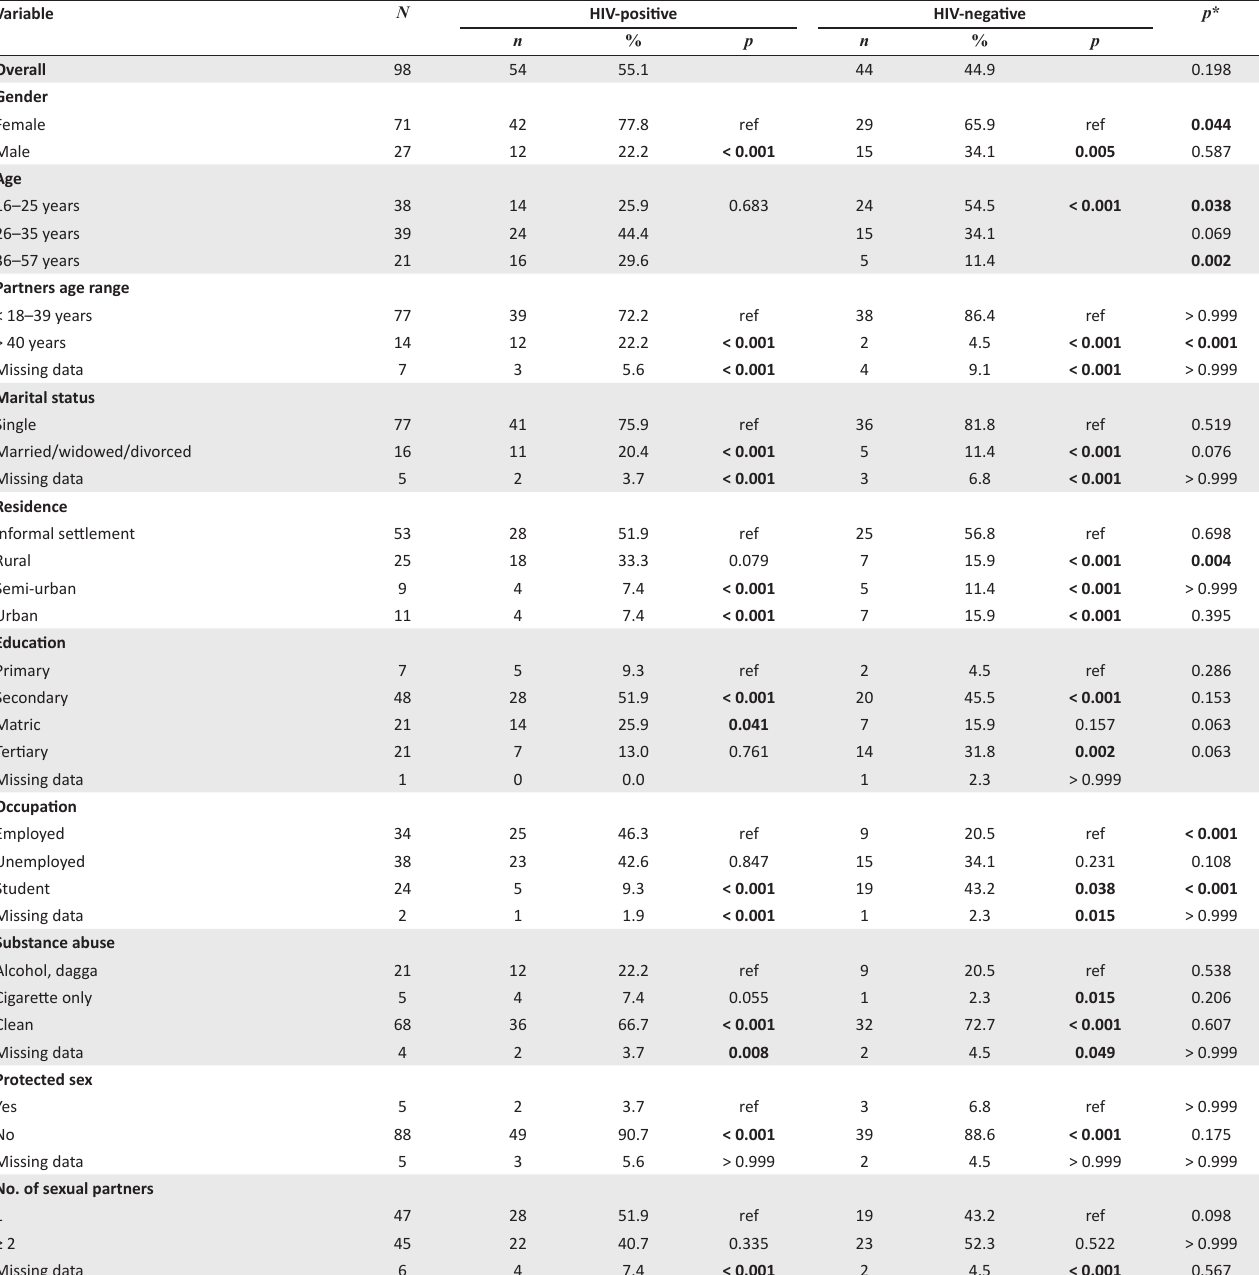
TABLE 5: Factors associated with Genital ulcer disease among HIV-positive and HIV-negative participants.